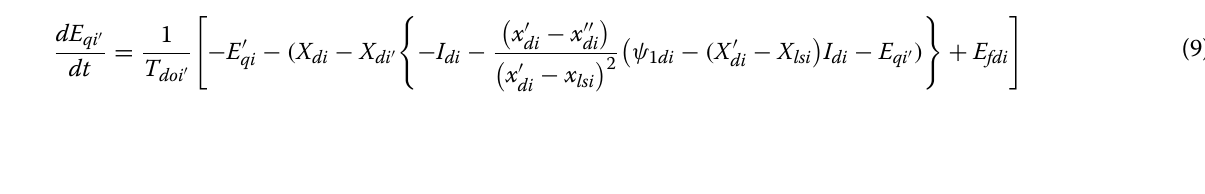
Similarly, I qi is the quadrature axis component of the stator current, and X ′′ qi , X ′ qi and X qi are the q-axis com- ponents of the sub-transient, transient, and synchronous